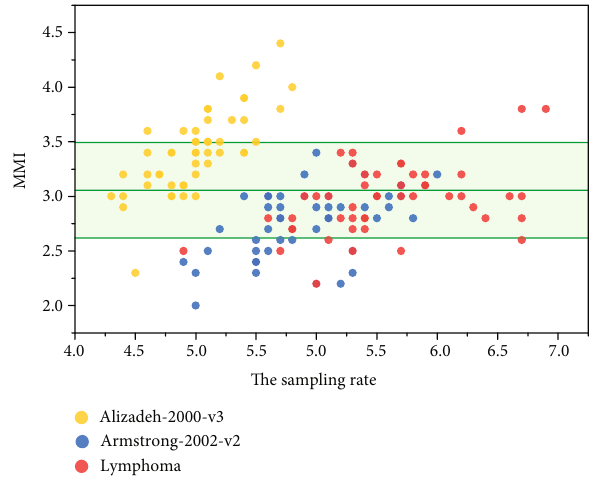
Figure 3: E ff ect of feature sampling rate on clustering